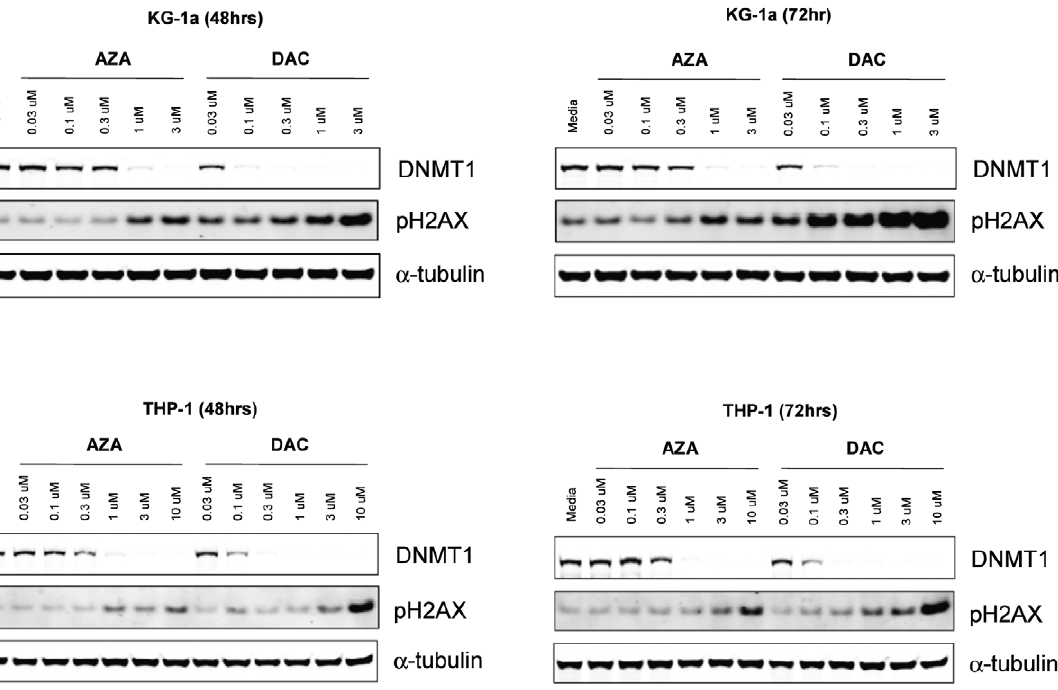
Figure 4. AZA and DAC cause DNMT1 depletion and induction of DNA damage in KG-1a and THP-1 cells. Cells were treated daily with AZA or DAC (0–3 m M in KG-1a; 0–10 m M in THP-1) for 48 and 72 hours. Protein lysates were analyzed by Western analysis for DNMT1 and phospho- H2AX (Ser 139) proteins. a -Tubulin is shown as a protein loading control. AZA = azacitidine; DAC = decitabine; DNMT = DNA methyltransferase.